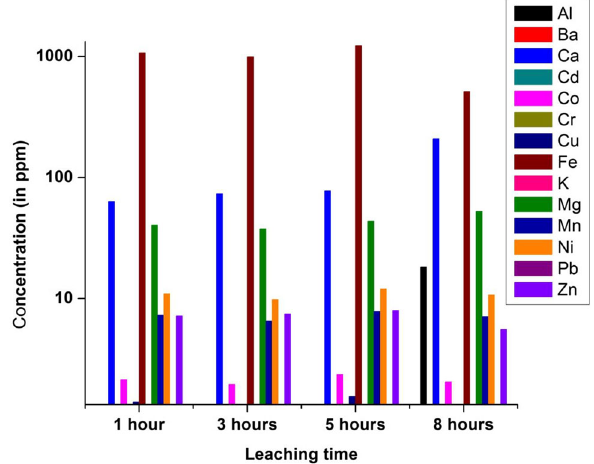
Fig. 23 Change in elemental concentration (in ppm) in aqueous leachates of Ledo coal (LC-20A) with leaching time (in hour) at 25 (cid:3)